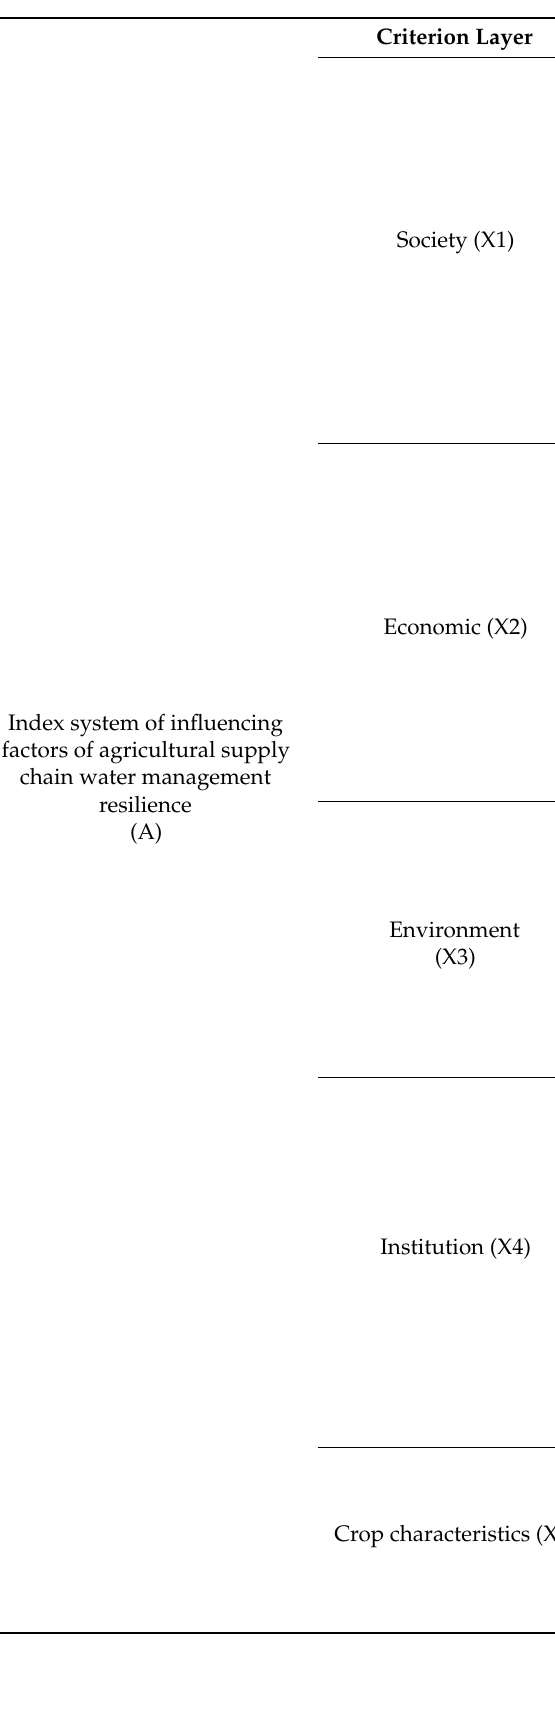
Table 3. Multiple influencing factors of agricultural supply chain water management